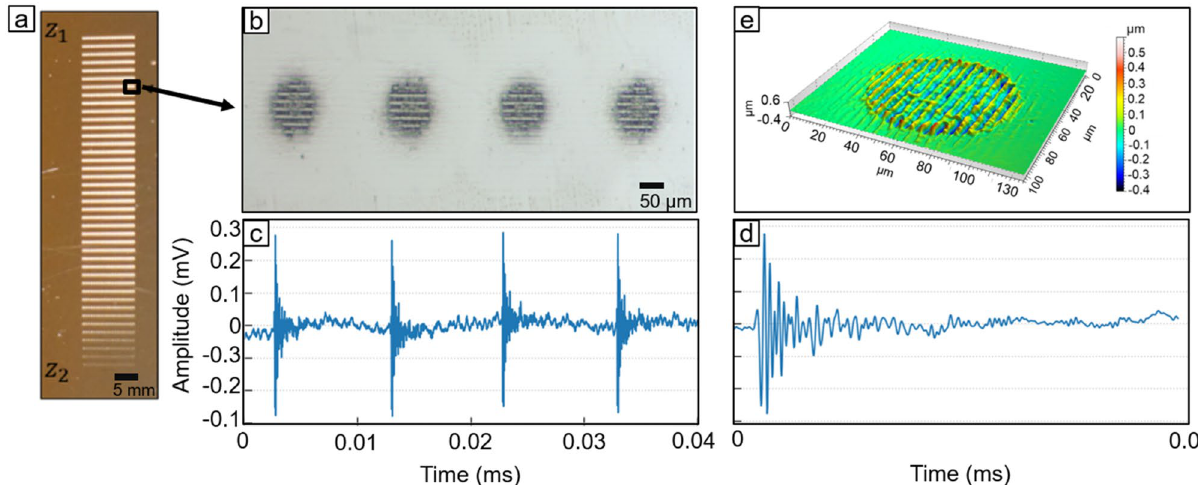
Figure 1. ( a ) Laser lines at different z1 working position to z2 to the focus length of the lens ( b ) Laser spot with interference pattern ( c ) Sound profile of four laser spots ( d ) Sound profile of one laser spot ( e ) Ablated spot with